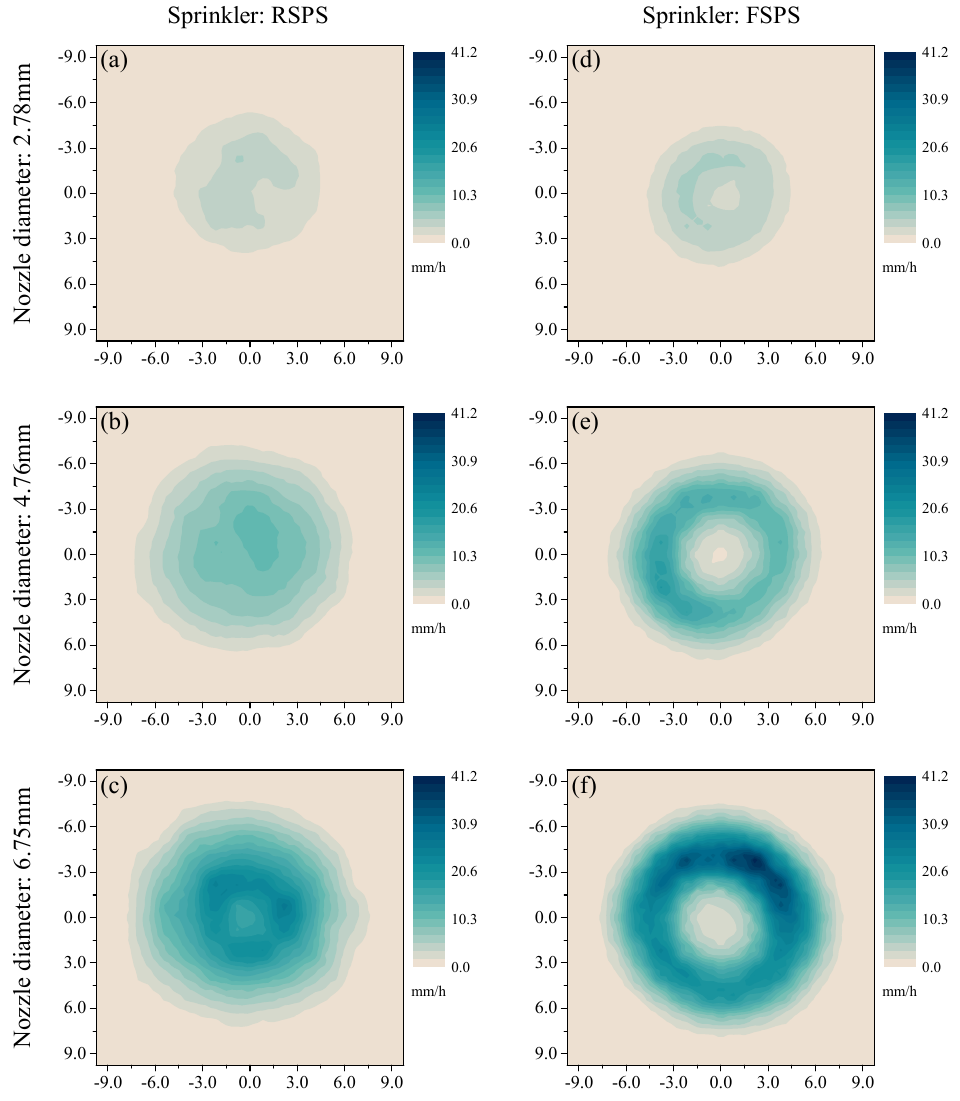
Figure 5. Water distribution characteristics of individual rotating spray plate sprinklers (RSPSs) and fixed spray plate sprinklers (FSPSs). The figures in different columns and rows indicate different sprinkler types (RSPS and FSPS) and nozzle diameters (2.78, 4.76, and 6.75 mm): RSPS—2.78 ( a ), RSPS—4.76 ( b ), RSPS—6.75 ( c ), FSPS—2.78 ( d ), FSPS—4.76 ( e ) and FSPS—6.75 ( f ).